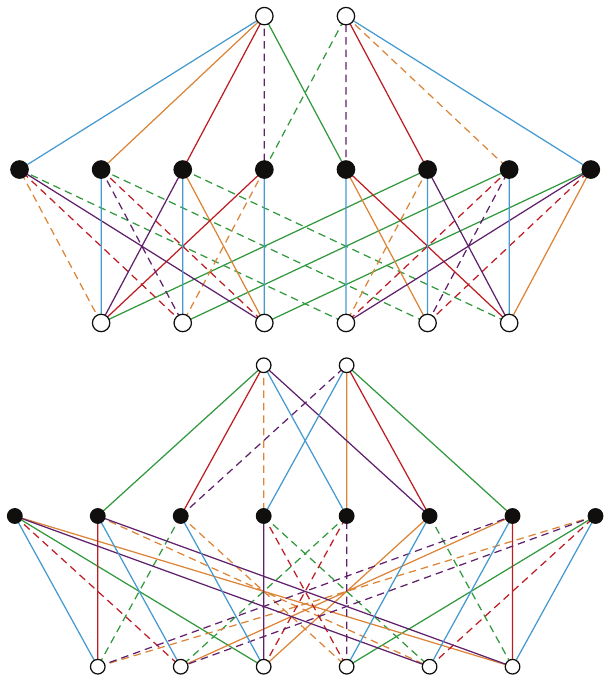
Figure 7: Two nonisomorphic height 3, (5,1) Adinkras belonging to the same equivalence